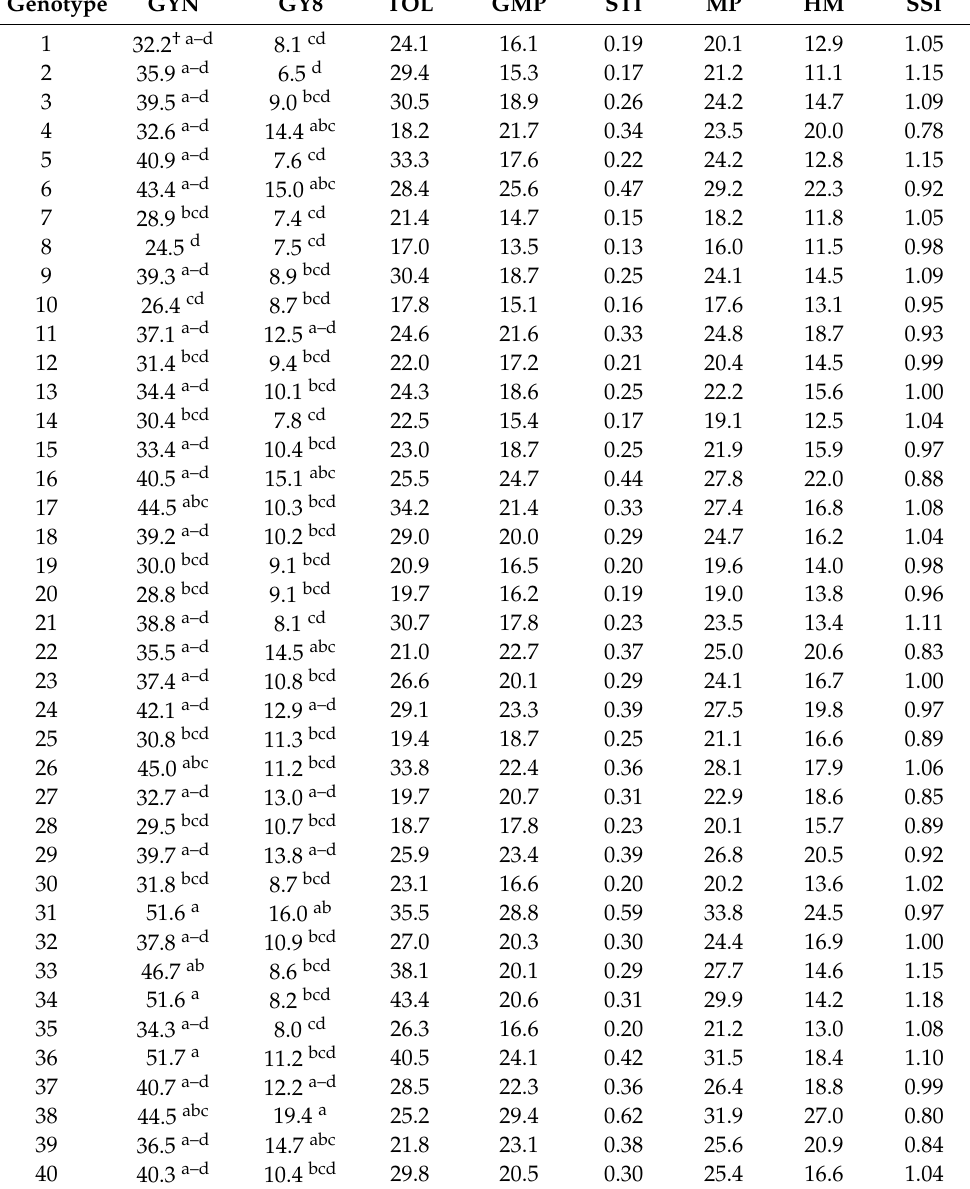
Grain yield of control (GYN), grain yield at 8.0 dS/m (GY8), and salinity toler- ance/susceptible indices of forty genotypes in 2019/20